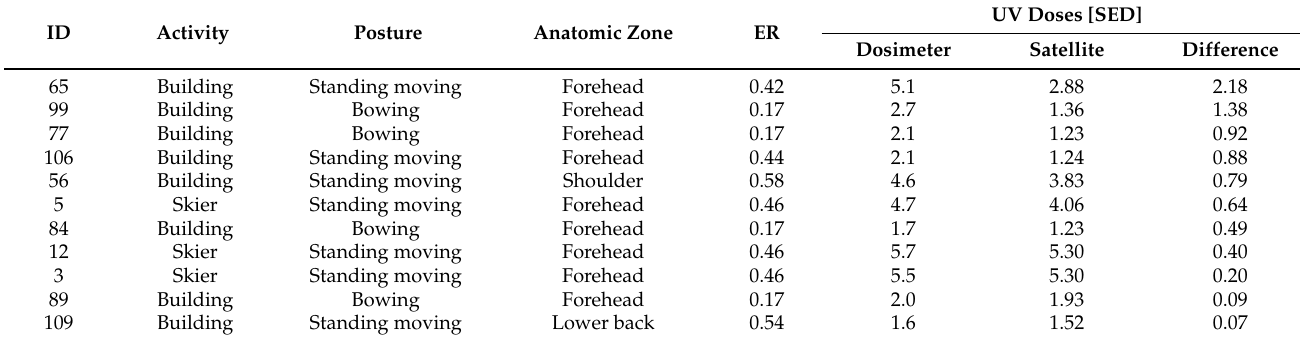
Table 2. Posture and dose information for points above the line of equality in Figure 2 sorted according to the magnitude of exceedance. The ID column can be used to identify these measurements in the Supplementary Table S1 available at https://www.mdpi.com/2073-4433/12/2/268/s1. The ER column gives the calculated Exposure Ratio and the Dosimeter and Satellite columns give the dosimetry measurements and the satellite-based personal UV dose estimates